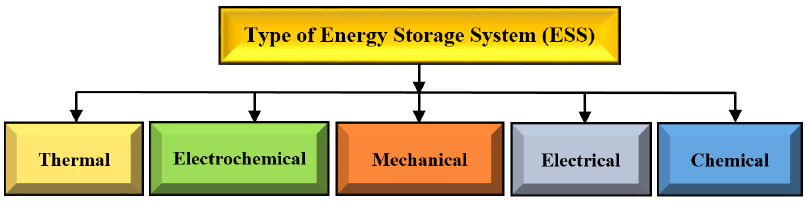
Figure 1. The classification of ESS technologies [6].